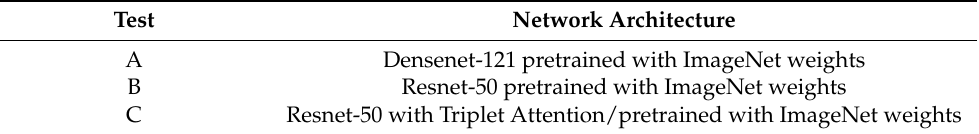
Table 3. Summary of Training/Test Scenarios.